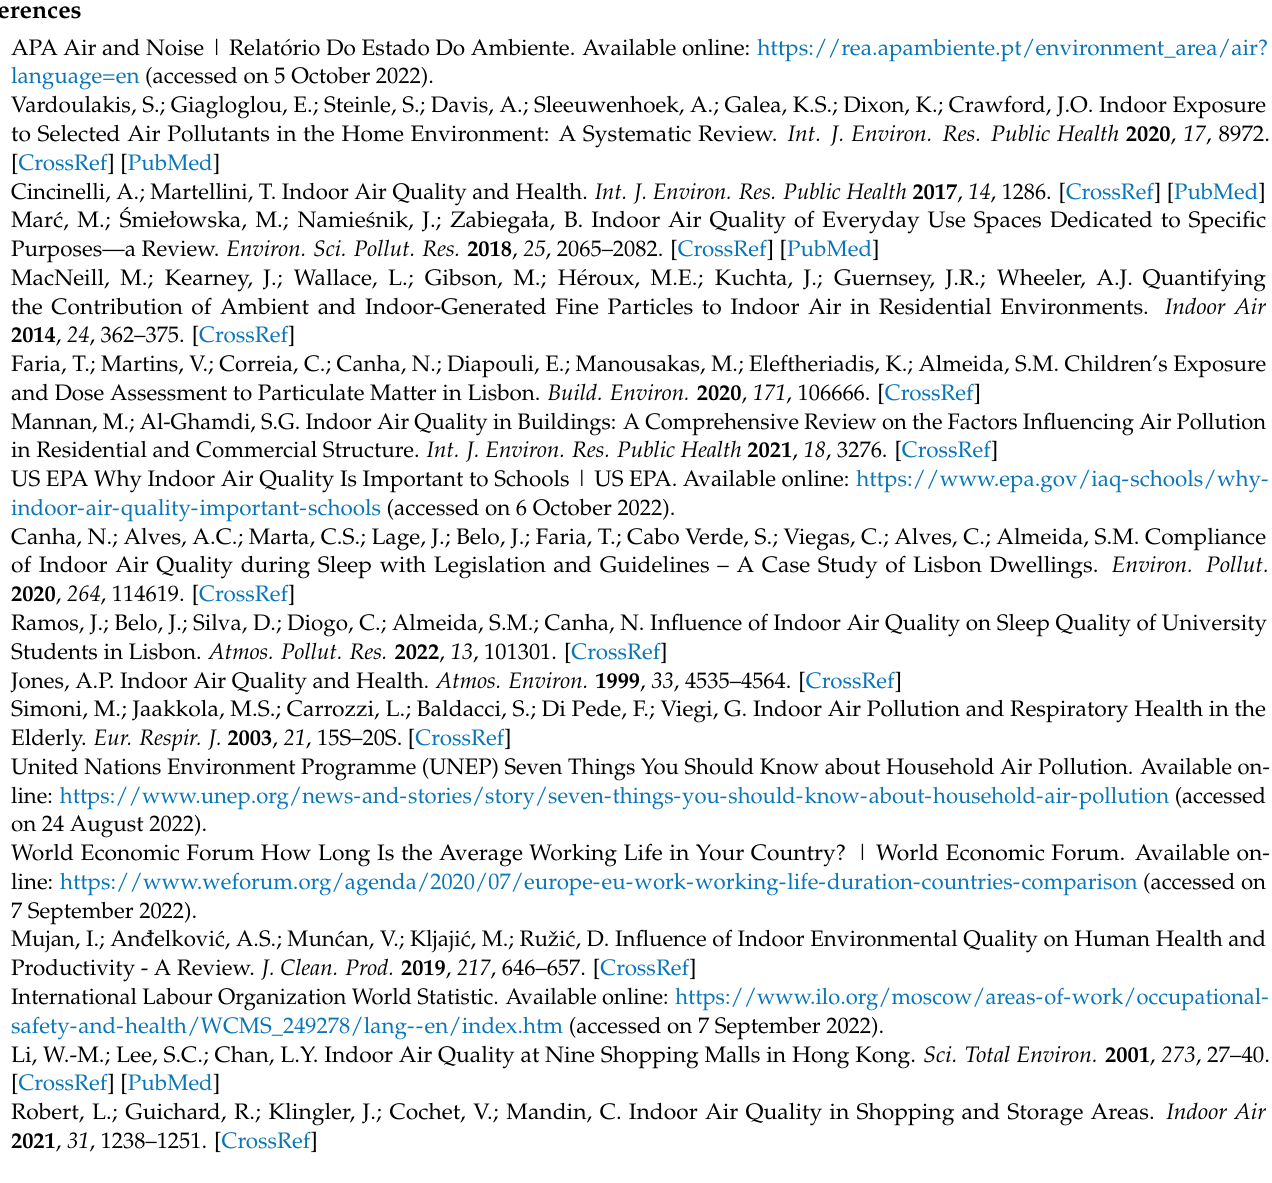
TS/SS—technical sheet/safety sheet; Table S2: Details of the performed monitoring campaign, including monitoring period and locations of the MBs within the